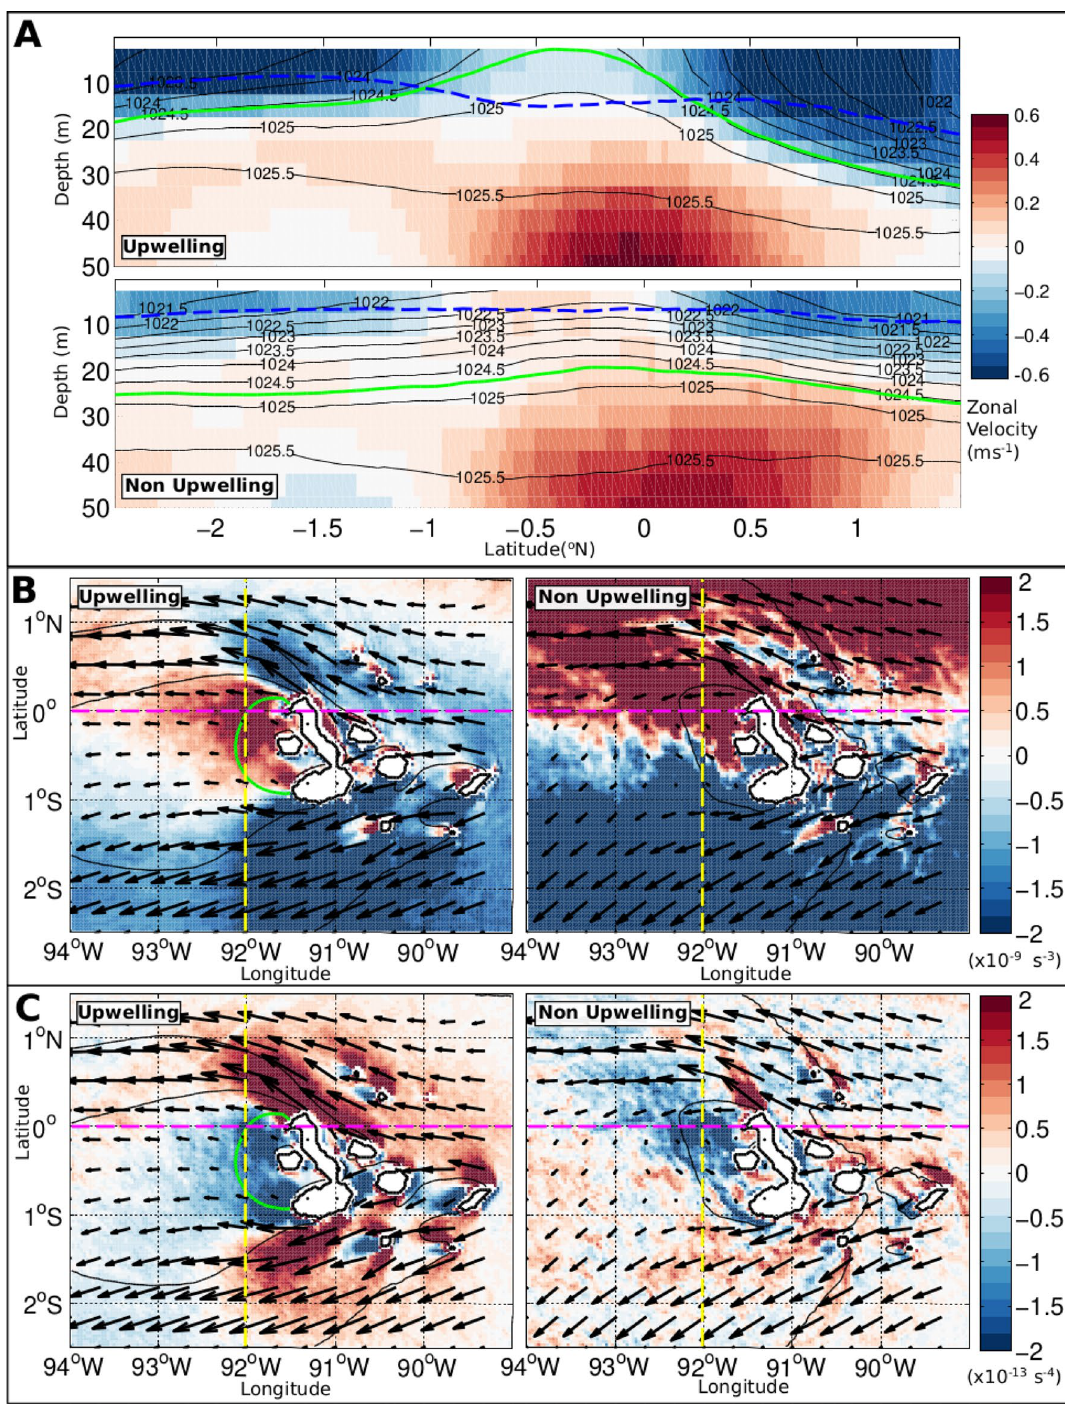
Figure 3. Model stratification and potential vorticity during upwelling and non-upwelling periods. ( A ) A section along 92ºW of mean zonal velocity, with density contours (black), mixed layer depth (blue), and 20ºC isotherm (green) means for periods of upwelling and non-upwelling conditions. ( B ) Full potential vorticity ( Q , s −3 ) averages for upwelling and non-upwelling periods, along with period-mean surface velocity vectors in black, where water speeds are in the range 0.01–0.83 m s −1 for upwelling periods and 0.01–0.73 m s −1 for non-upwelling periods. ( C ) Q flux vector ( J F z , s −4 ) and mean surface velocity vectors in black for upwelling and non-upwelling periods. The location of the density section shown in panel ( A ) is marked as a yellow dashed line, and the equator as a magenta dashed